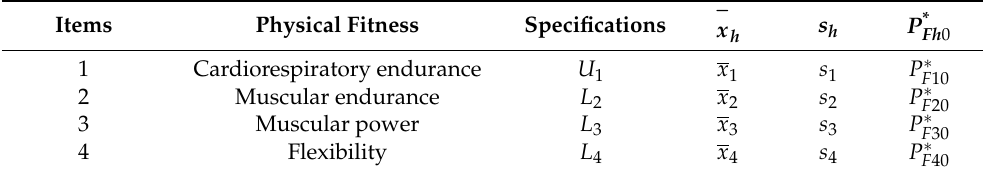
Table 1. Testing statistics and index estimates of four physical fitness items.